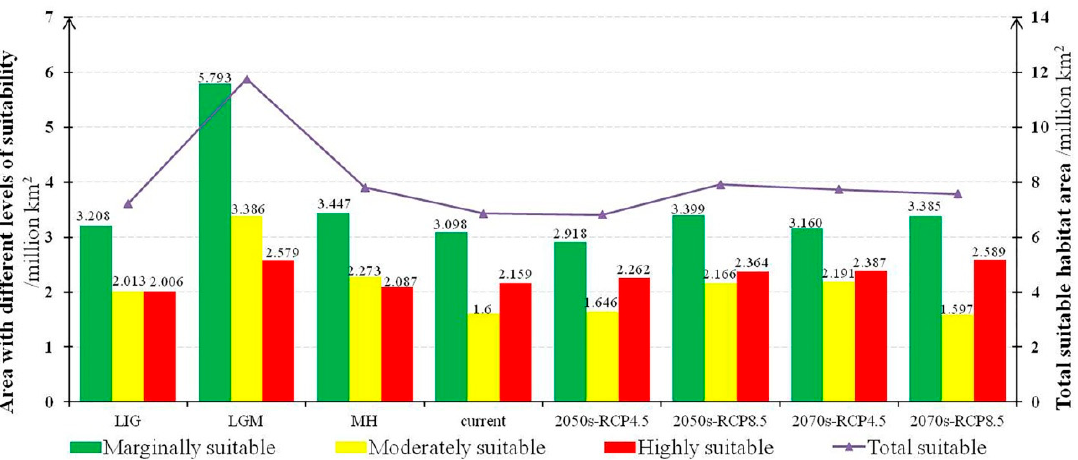
Figure 5. The total suitable habitat area and habitats with different levels of suitability under each climatic scenario. The details of the abbreviation in this figure are same as Figure 2.